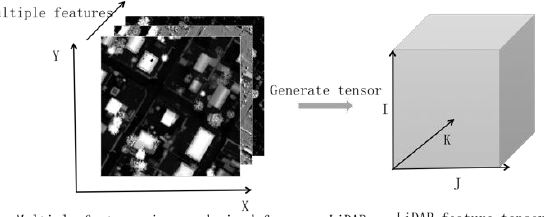
Figure 1. Feature Tensor generation